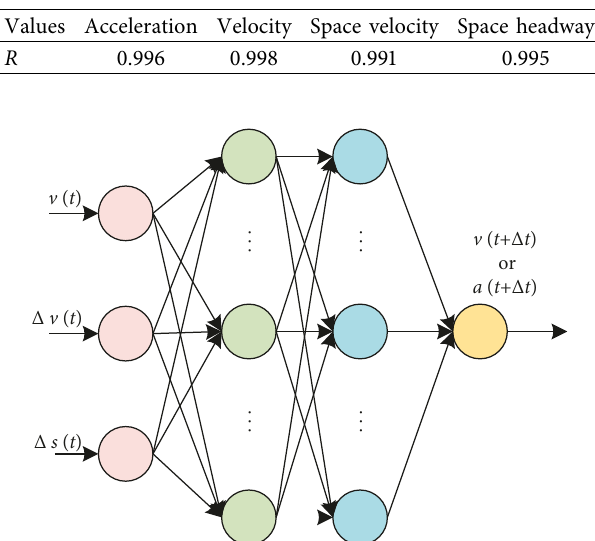
Figure 4: The structure of the BP neural